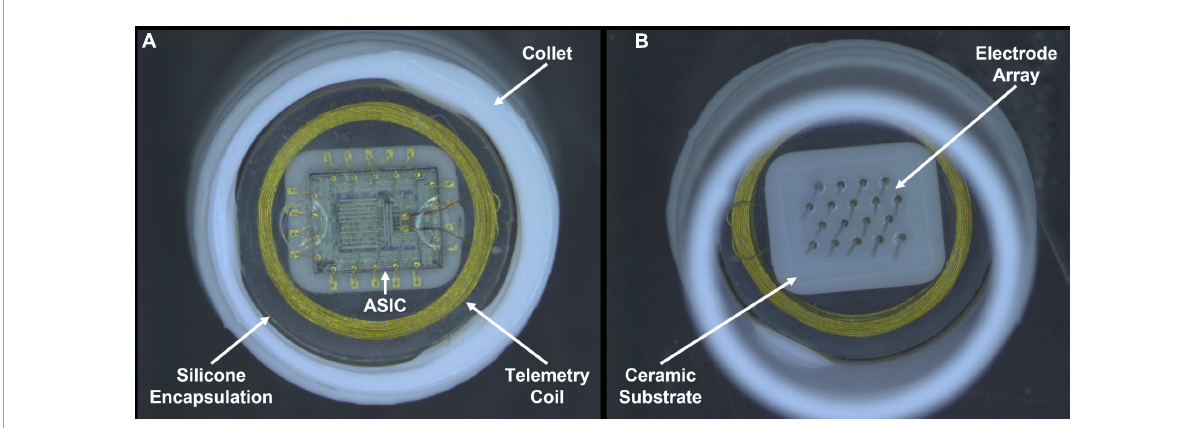
FIGURE1 Photographs recorded after pulsing in LP-PBS for 24 days. One wireless floating microelectrode array (WFMA ID W0124_64_187) from the pulsed group of devices is shown inside a white collet used for device handling. (A) Backside of the WFMA viewed from underneath showing the gold wire telemetry coil, application-specific integrated circuit (ASIC), silicone encapsulation, and white collet used to contain each device during testing. (B) WFMA viewed from above showing the microelectrodes coming out of the ceramic substrate and silicone device encapsulation. No evidence of degradation was observed for the encapsulation, ASIC, or microelectrode array at the end of the 24-day pulsing